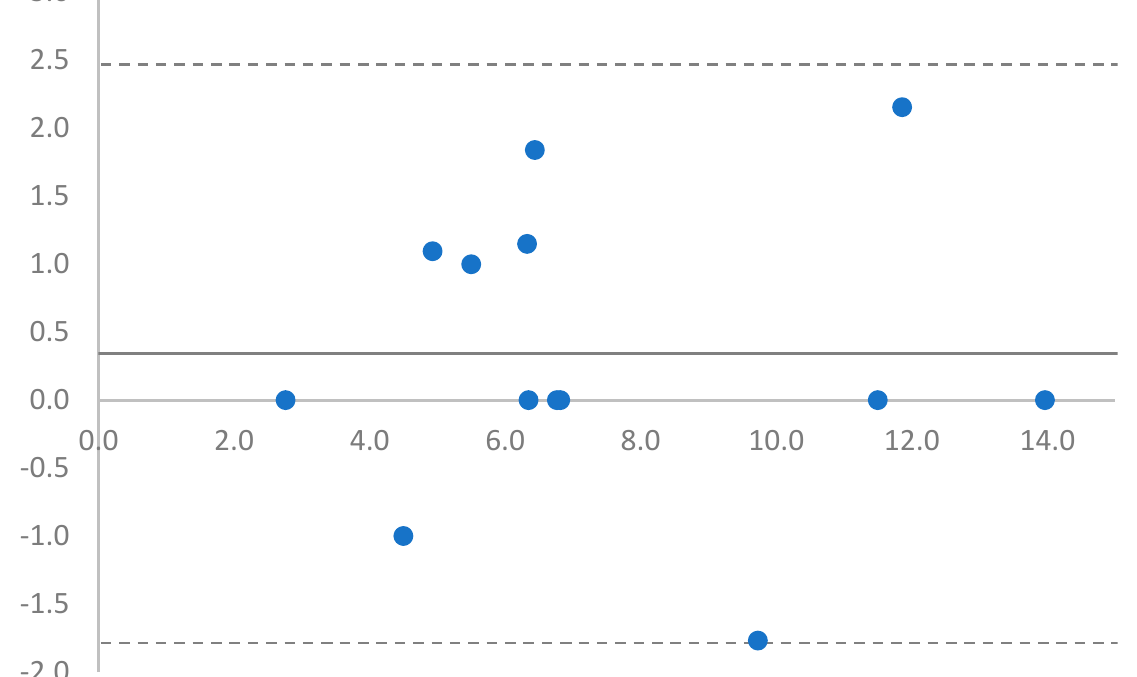
Figure 1. Bland–Altman Plot of erythrocyte sedimentation rate (ESR) measurements between the Westergren and micro-ESR methods. Dotted lines are ± 1.96 standard deviations from mean (solid black line). All data points are between 1.96 standard deviations signifying good agreement between methods.